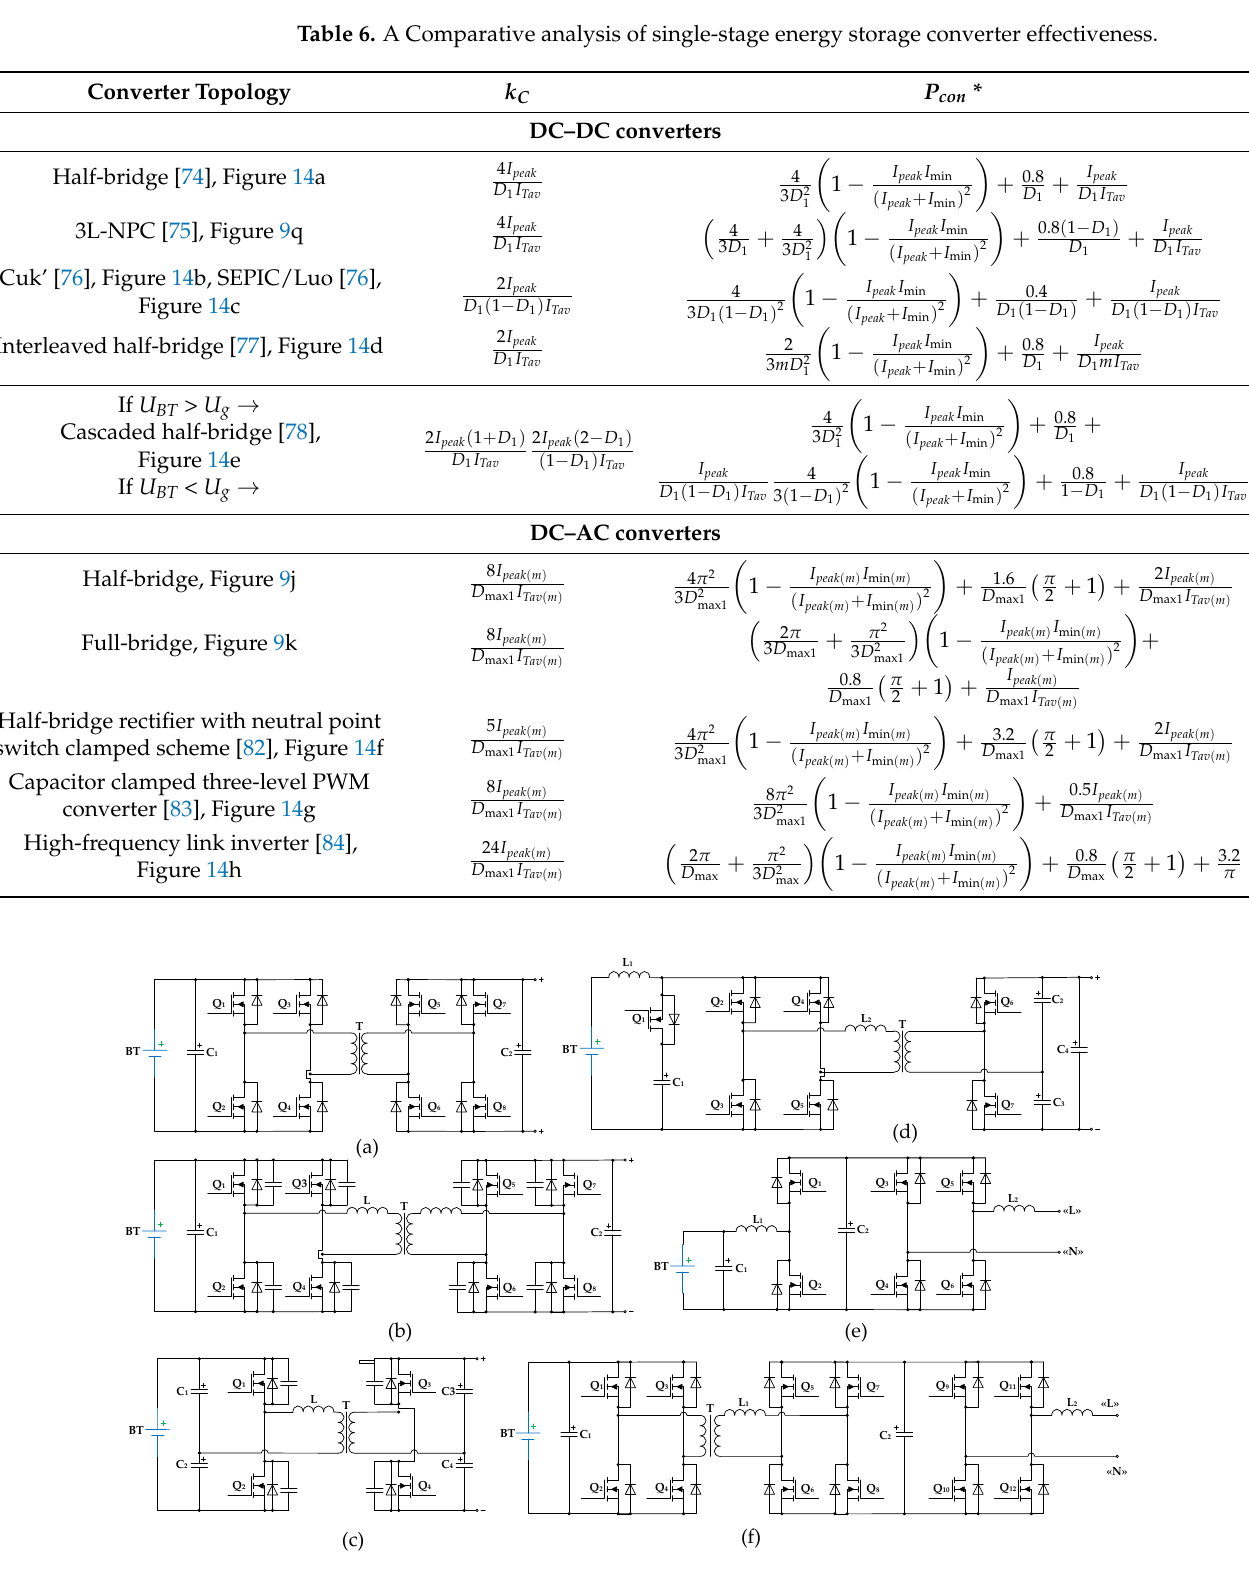
Figure 15. Converters for two-stage storage applications: ( a ) dual active bridge; ( b ) dual active bridge soft-switching; ( c ) with two voltage-fed half-bridges; ( d ) combined voltage- half-bridge and current-fed full-bridge; ( e ) half-bridge and full-bridge; ( f ) full-bridge DC – AC and dual active bridge DC – DC. Table 6. A Comparative analysis of single-stage energy storage converter effectiveness.